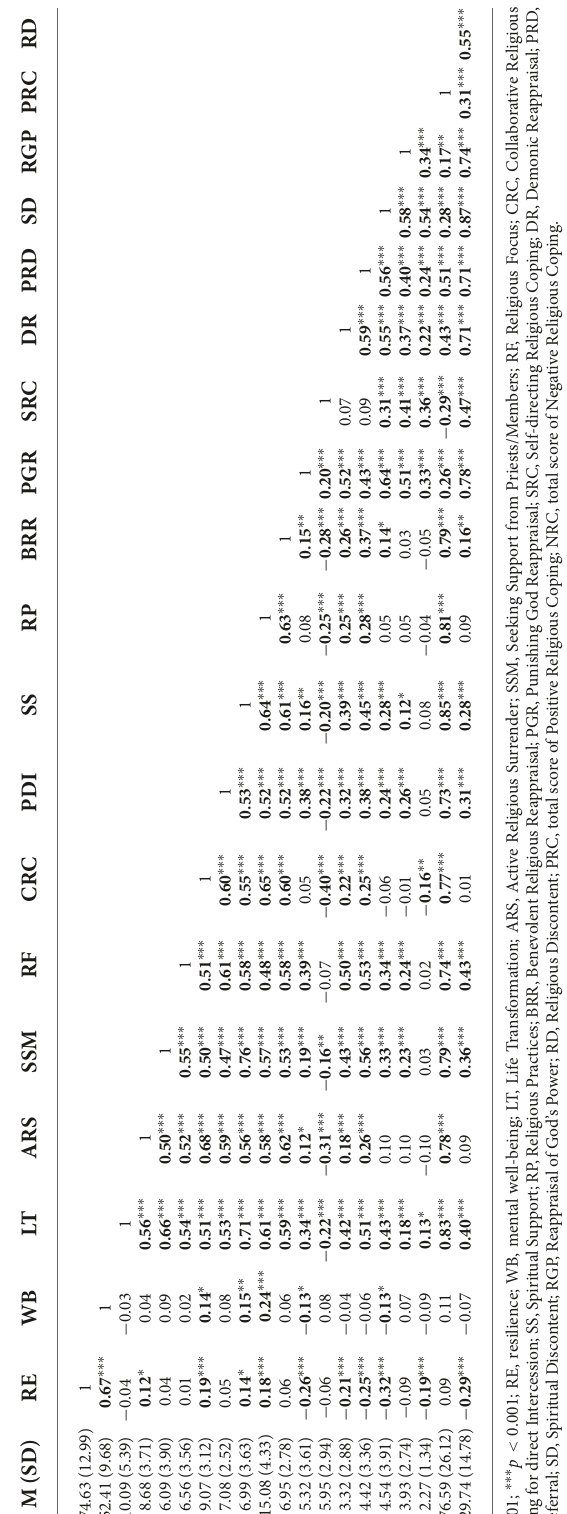
The a path for demonic reappraisal totaled β = −